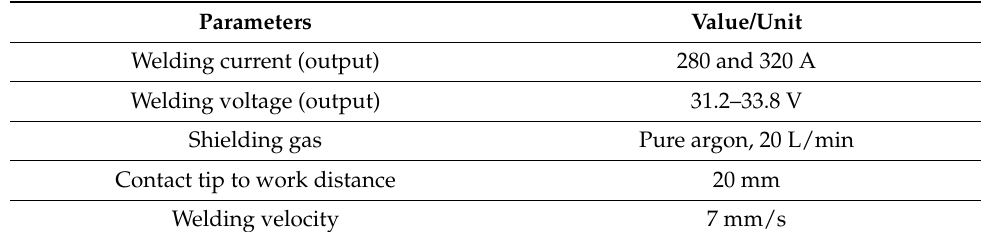
Table 4. Summary of welding conditions.